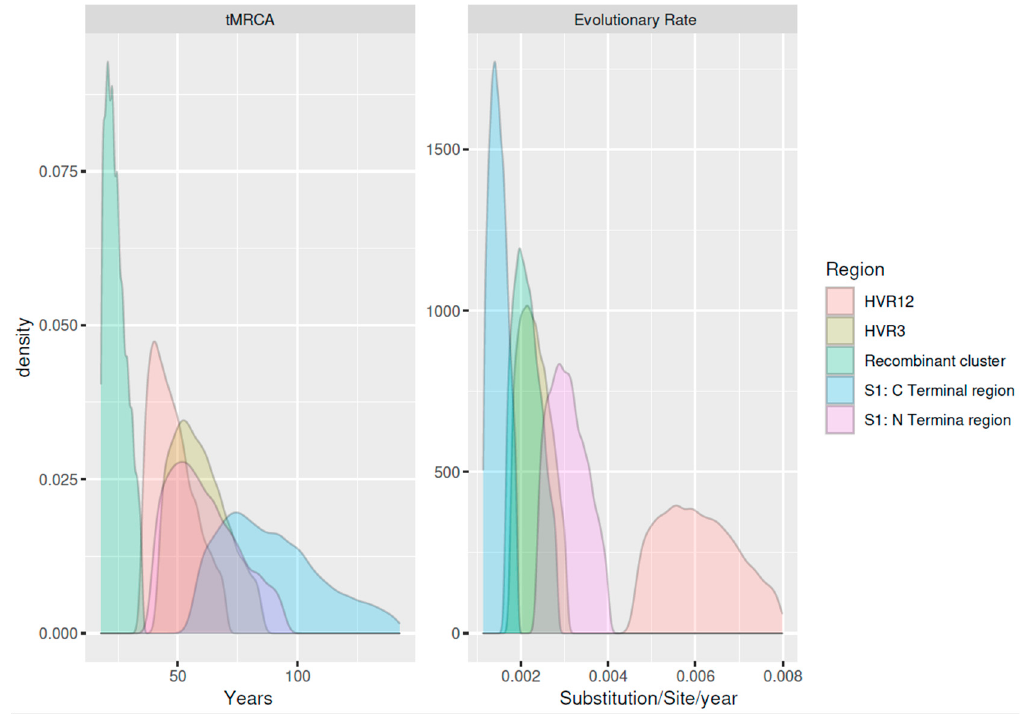
Figure 2. Density plots reporting the estimated tMRCA ( left ) and evolutionary rate ( right ). Results of different datasets have been color-coded.